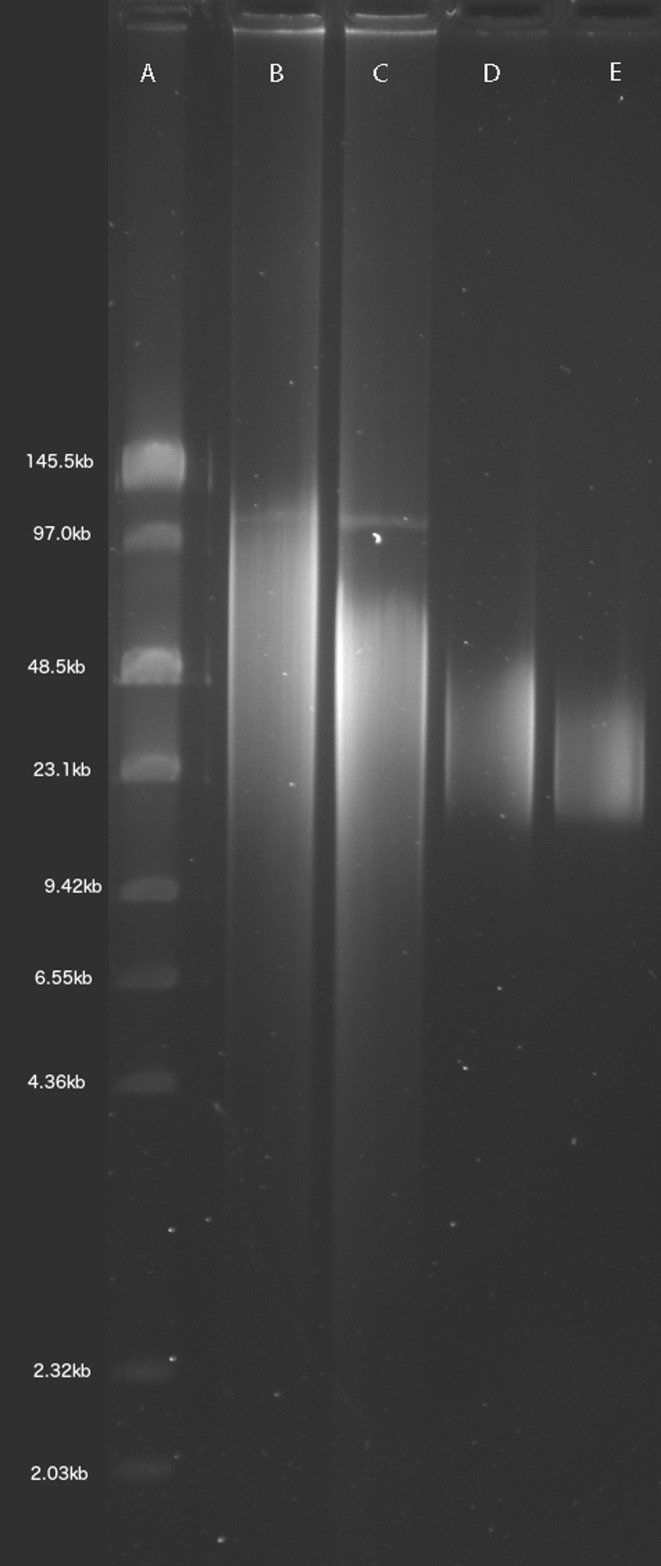
An example of correctly extracted and sheared DNA visualized using field inversion gel electrophoresis. The ladder is the NEB low range PFG marker (no longer produced). The lanes of the gel are as follows: (A) ladder, (B) unsheared DNA, (C) DNA sheared with a 24 gauge needle, (D) sheared DNA size selected with 15–50 kb cut-off, (E) SMRTbell template library after 15–50 kb size selection. From the gel, it is evident that there is a minimal ‘tail’ of DNA below ∼15 kb, the preferred size selection minimum.